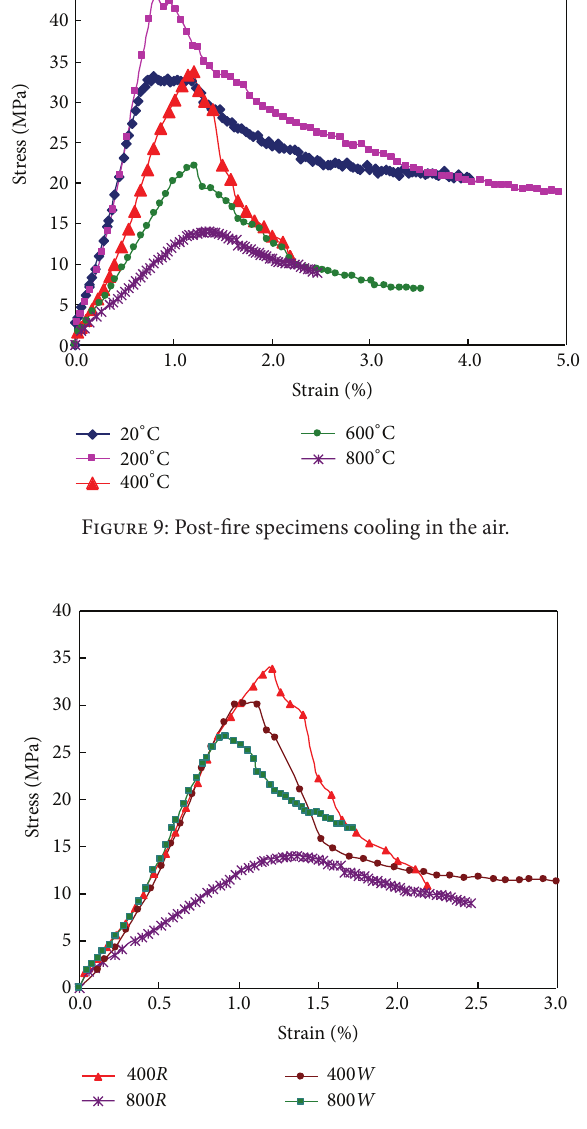
Figure 10: Stress-strain curve of specimens subjected to different cooling